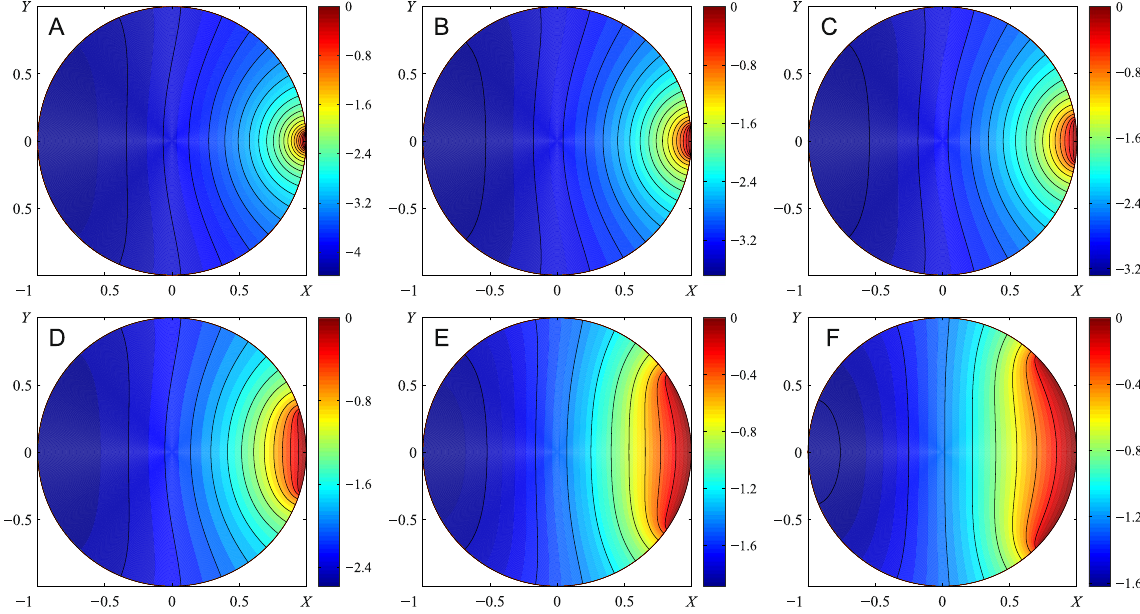
Figure 6. Dimensionless pressure distribution P − K c for different ratios of the food canal diameter |AB| to chamber diameter 2 R. ( A ) | AB |/(2 R ) = 0.05, ( B ) |AB|/(2R) = 0.01, ( C ) | AB |/(2 R ) = θ = 0.15, ( D ) |AB|/ (2 R) = 0.3, ( E ) | AB |/(2 R ) = θ = 0.6, ( F ) | AB |/(2 R ) = θ = 0.78. The color bar sets the pressure level. Black lines indicate constant pressure; the two nearest lines have a dimensionless pressure difference of